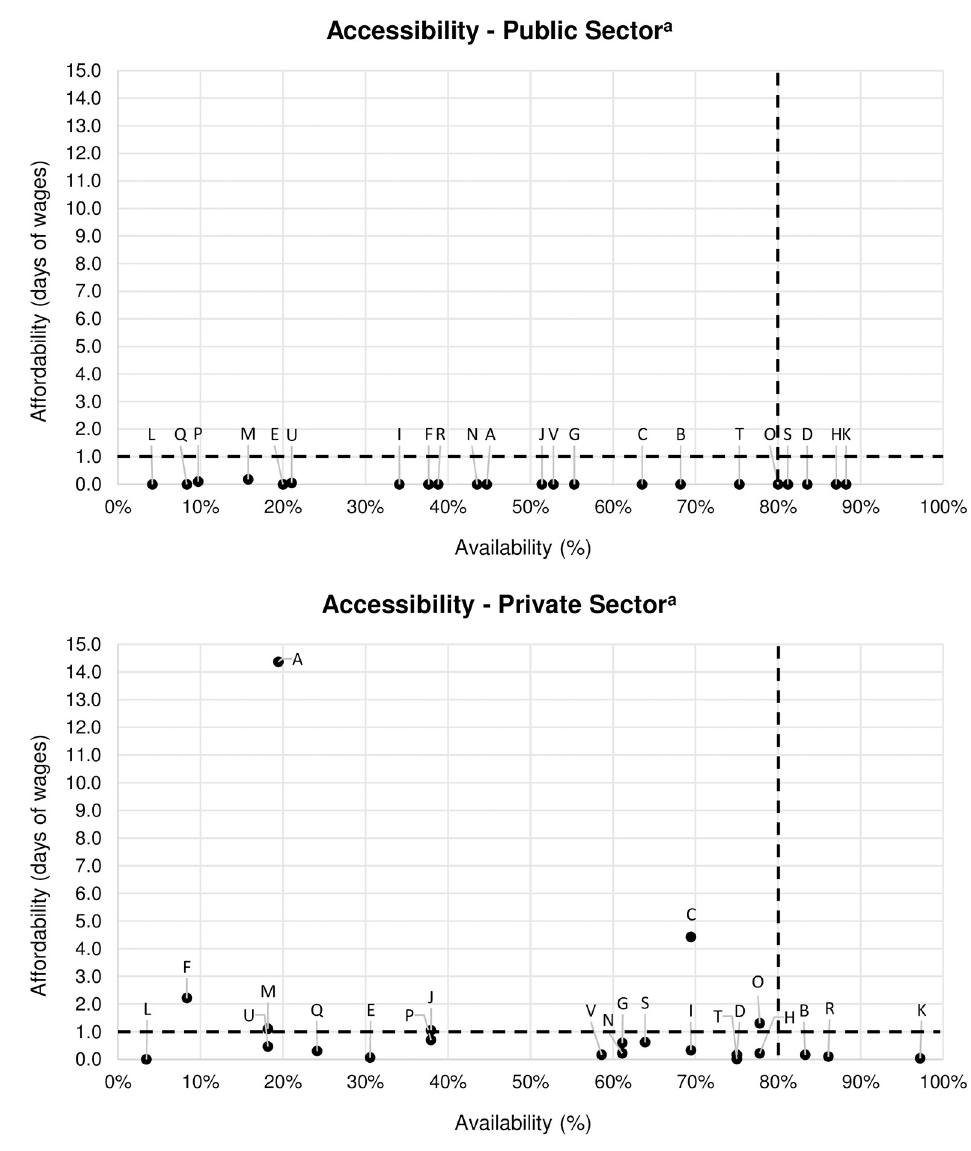
Fig 1. Accessibility of snakebite commodities, per